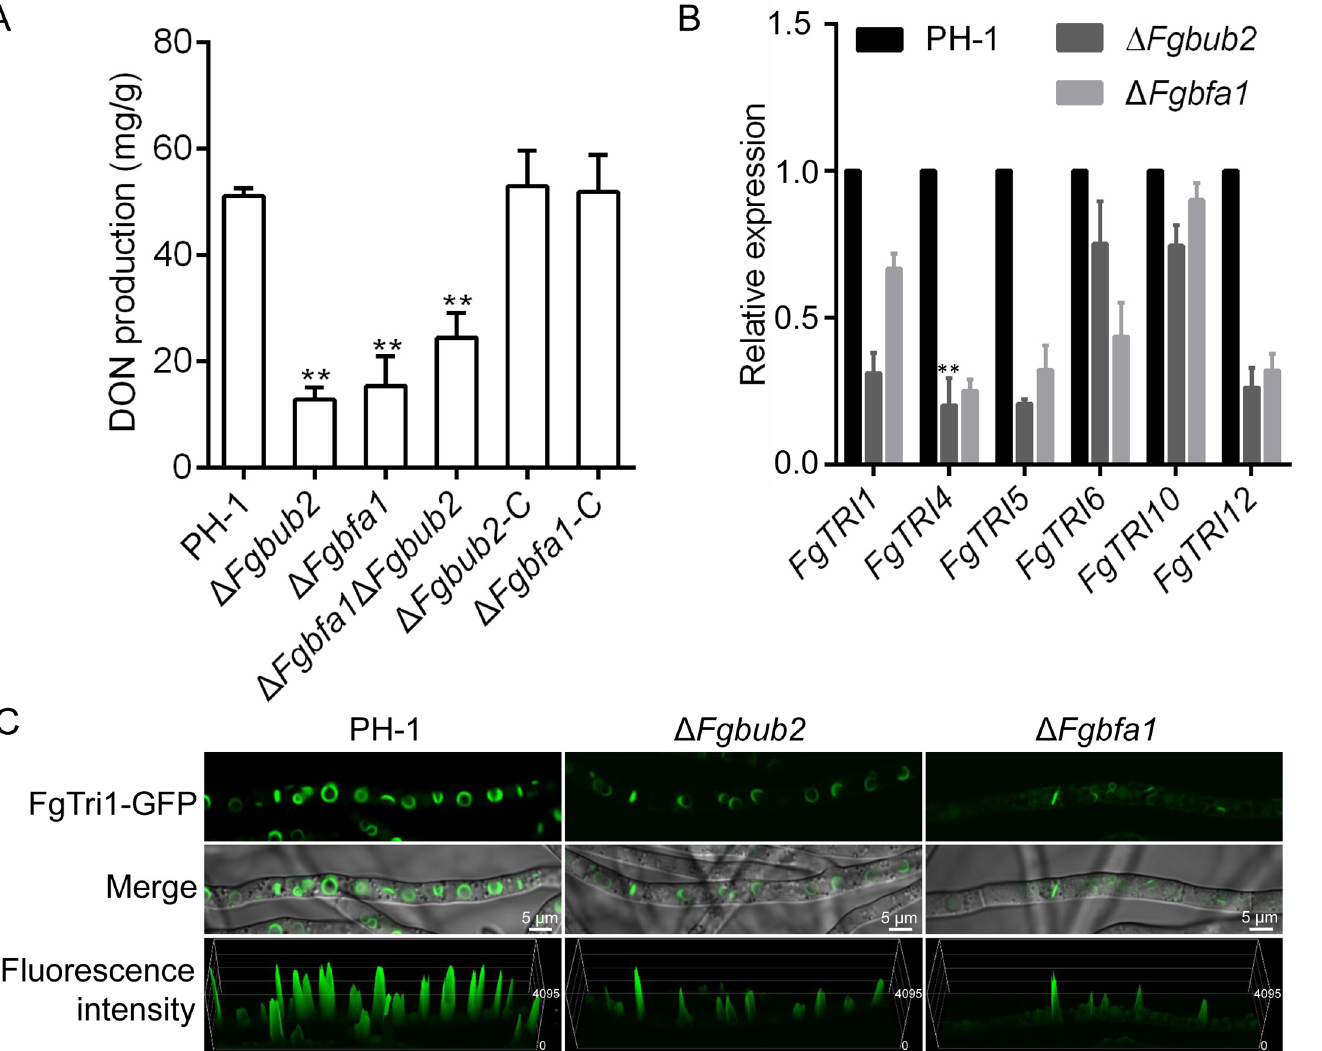
Fig 8. FgBub2 and FgBfa1 are both required for DON production in F. graminearum . (A) Amounts of DON produced by the wild type PH-1, Δ Fgbub2 , Δ Fgbfa1 , Δ Fgbfa1 Δ Fgbub2 , Δ Fgbub2 -C and Δ Fgbfa1 -C strains in liquid TBI media after incubation for 7 days. The Δ Fgbub2 , Δ Fgbfa1 and Δ Fgbfa1 Δ Fgbub2 mutants had significantly reduced levels of DON. Asterisks indicate significant differences. Two-tailed Student t -test was used for paired comparison of the DON produced by PH-1 and the different mutants, respectively. ( �� P < 0.01). (B) The relative expression levels of FgTRI1 , FgTRI4 , FgTRI5 , FgTRI10 and FgTRI12 genes in the PH-1, Δ Fgbub2 and Δ Fgbfa1 strains cultured in liquid TBI media for 3 days. Two-tailed Student t -test was used for paired comparison of the TRI genes in PH-1 and the different mutants, respectively. ( �� P < 0.01 or � P < 0.05). (C) The expression of FgTri1-GFP in PH-1, Δ Fgbub2 and Δ Fgbfa1 strains. FgBub2 and FgBfa1 are dispensable for toxisome formation. However, the fluorescence intensity of the FgTri1-GFP in the Δ Fgbub2 and Δ Fgbfa1 mutants are lower than those in the PH-1.